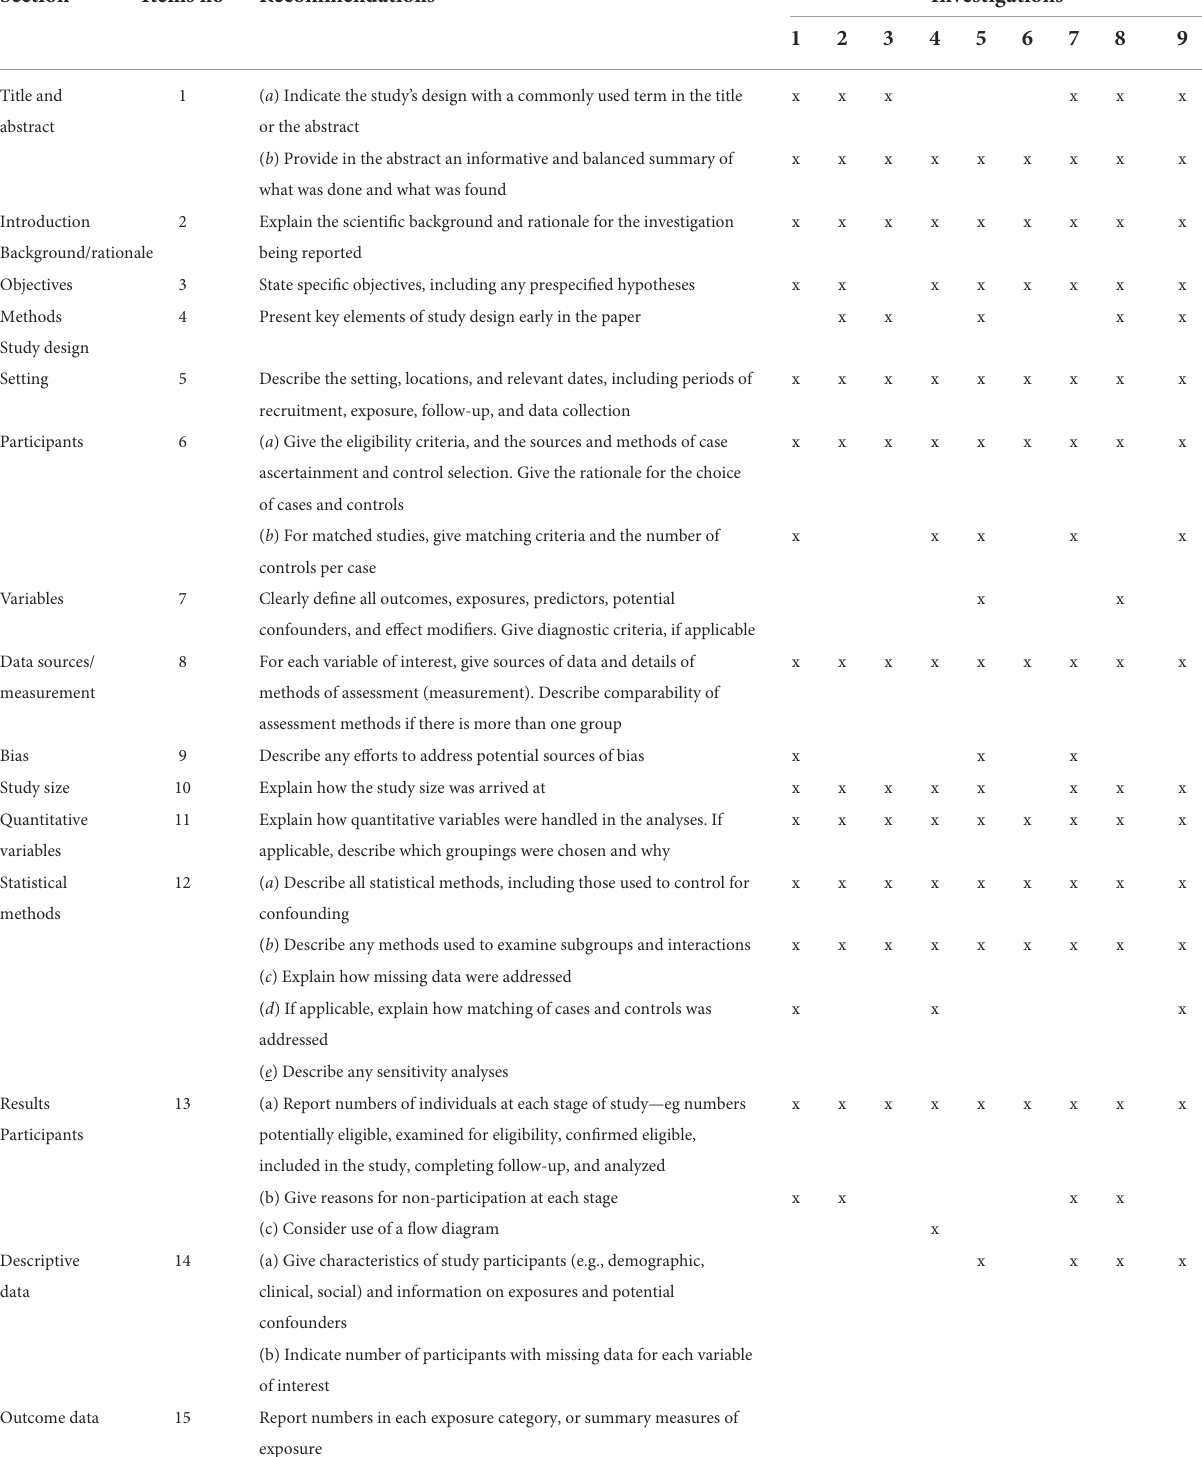
TABLE 1 STROBE statement—checklist of items that should be included in reports of case-control